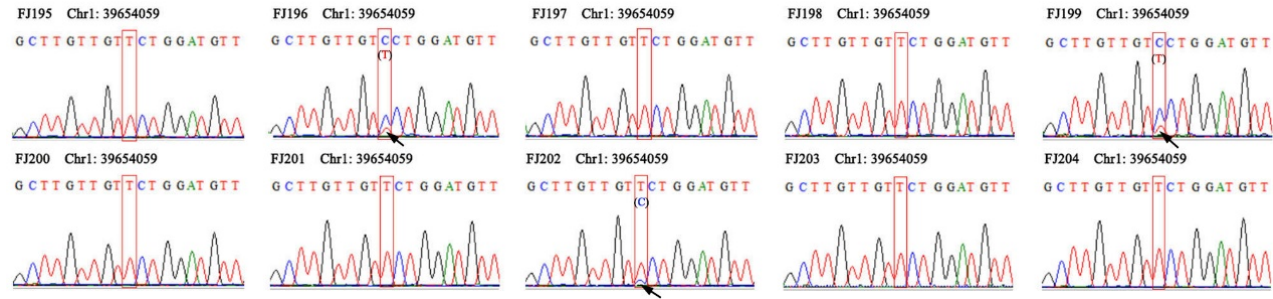
Figure 6. Primers were randomly verified by PCR. Randomly select 10 samples for first-generation sequencing and typing; arrows indicate clearly identifiable heterozygous sites.